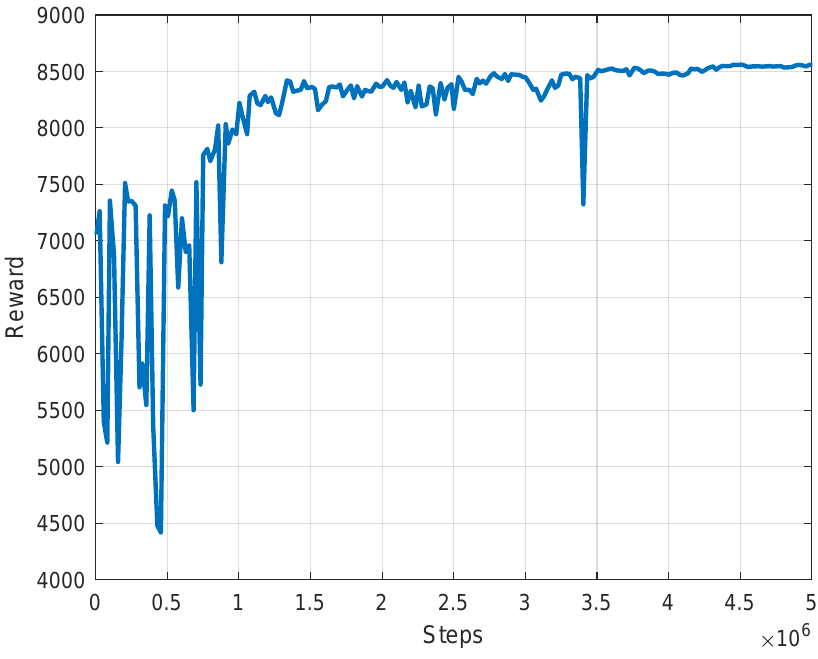
Figure 7. The reward of the learning